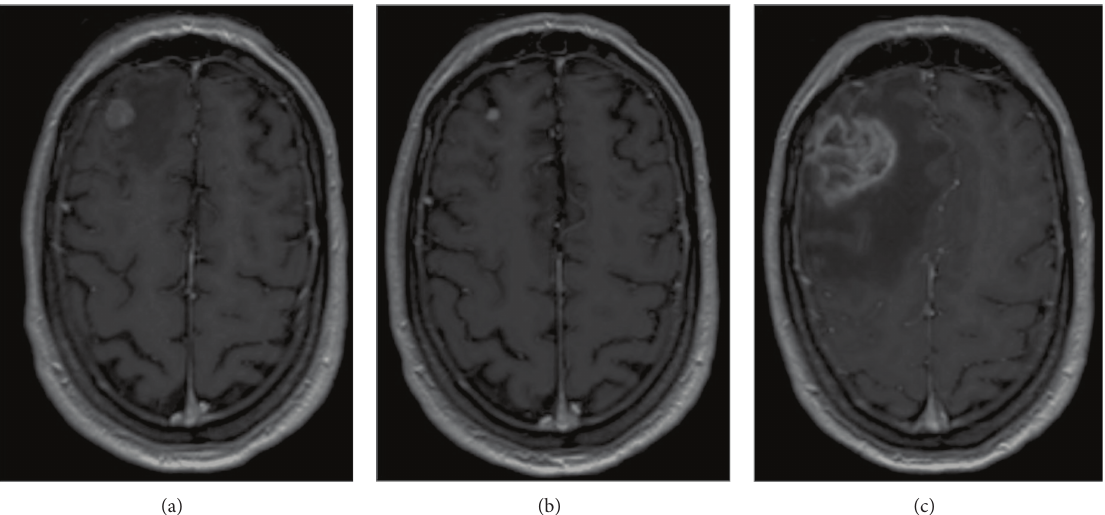
Figure1:Gadolinium-enhancedT1-weightedMRIimagesobtained(a)atdiagnosis,(b)6monthsafterSRT,and(c)atoccurrenceofsymptoms 9 months after